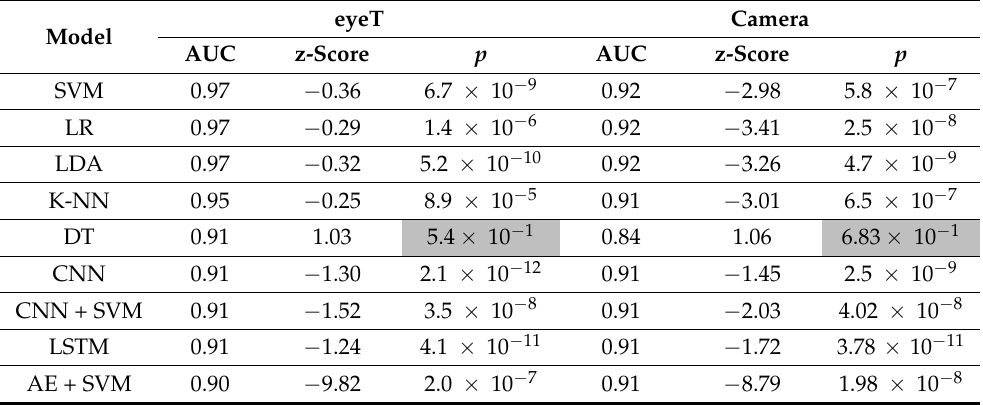
Table 7. Summary of the delong’s test to compare auc values at significant levels 0.05 and comparison of z-scores and p -values between